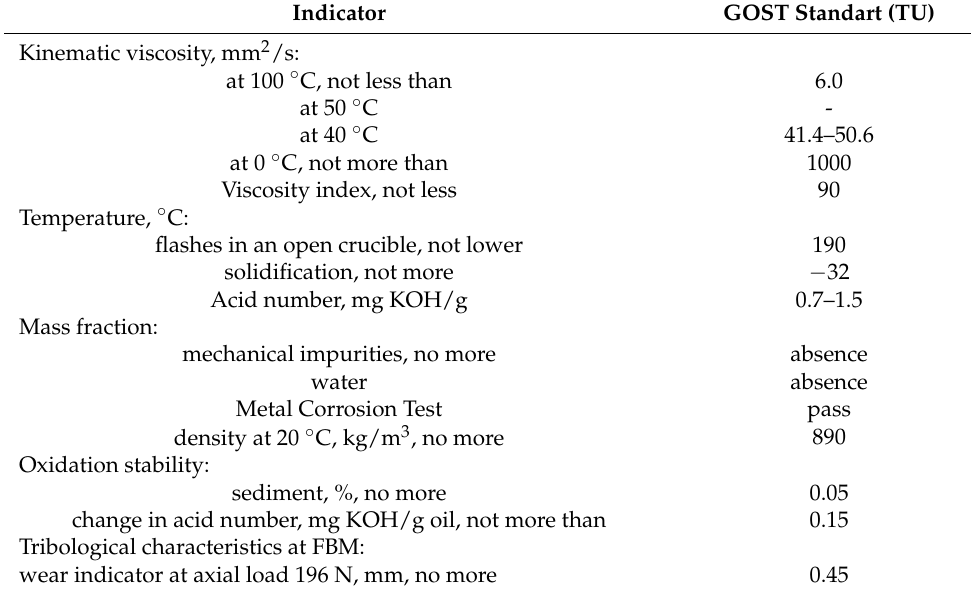
Table 1. Rosneft MGE-46V hydraulic oil